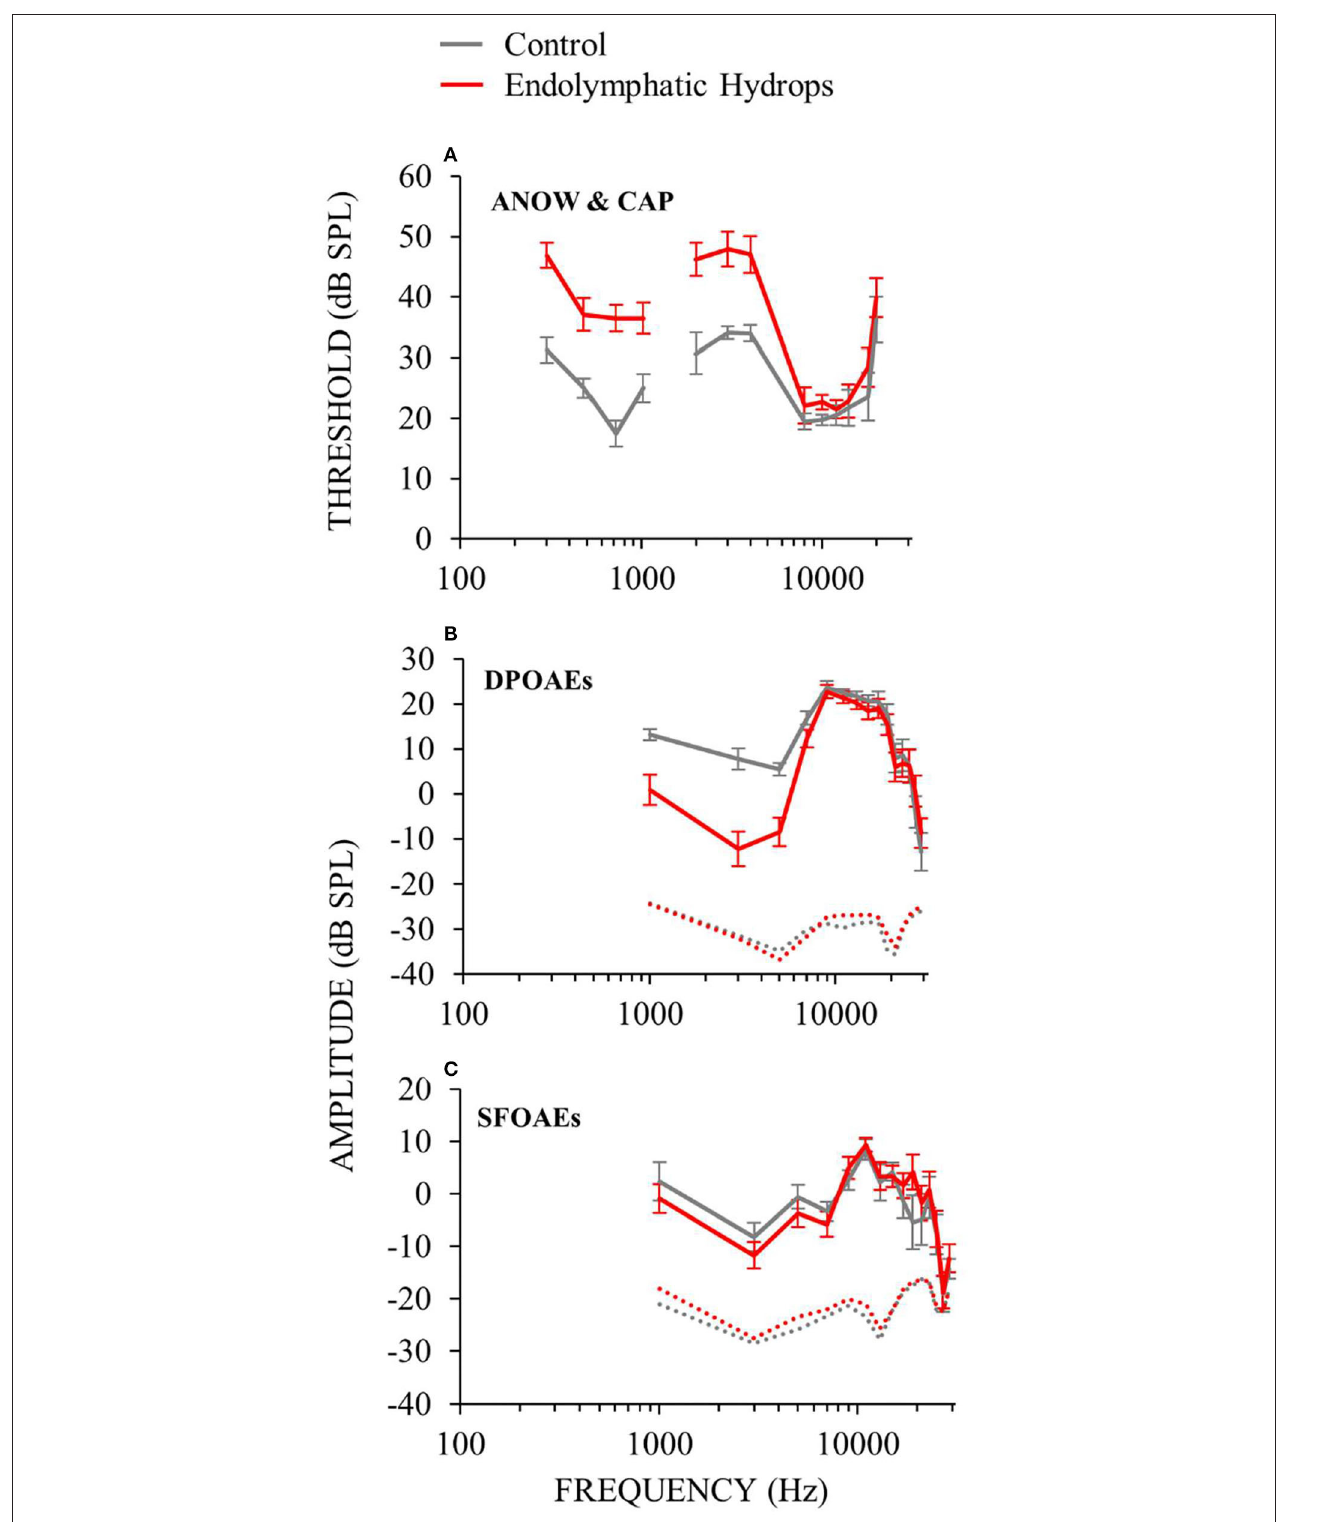
FIGURE 2 | Cochlear function measurements from experimental (red) and control (gray) animals. Data from the right ears of 18 guinea pigs 30 days after ablation of the endolymphatic sac, and from 8 control animals, 4 of which had undergone sham surgery. Error bars are one standard error of the mean. Operated animals had hearing dysfunction at low ( ≤ 1) and mid (2–4kHz) frequencies, but not high frequencies. See elevated hearing thresholds (A) , decreased DPOAEs (B) and decreased SFOAEs (C) .